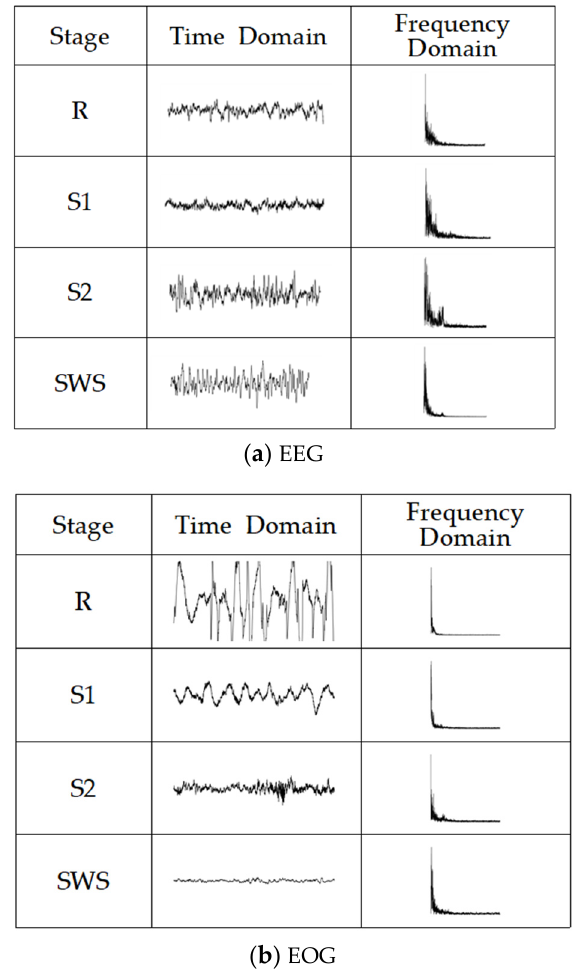
Figure 2. Images of time domain and frequency domain for each sleep stage: ( a ) EEG; ( b ) EOG.